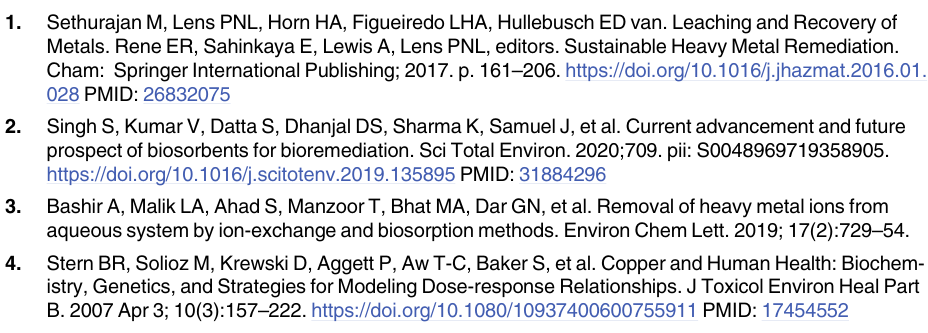
) capacity and recovery efficiency of copper des